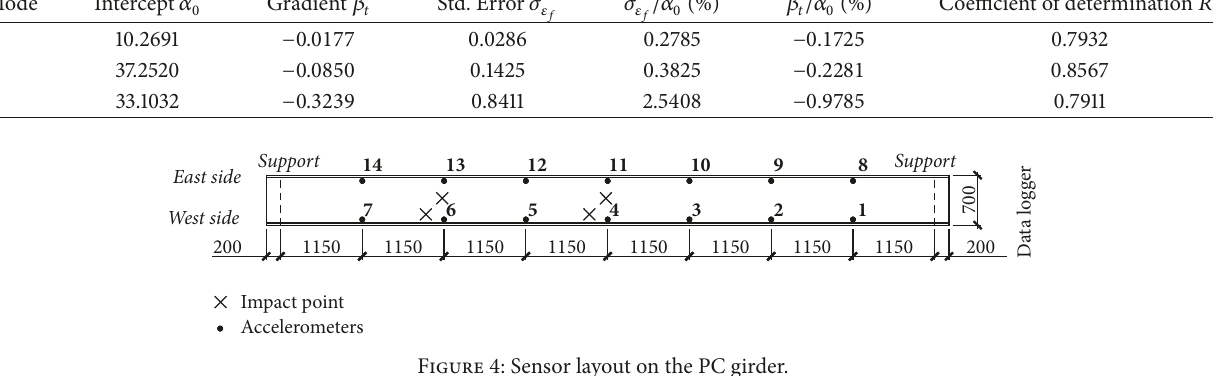
Figure 4: Sensor layout on the PC girder.